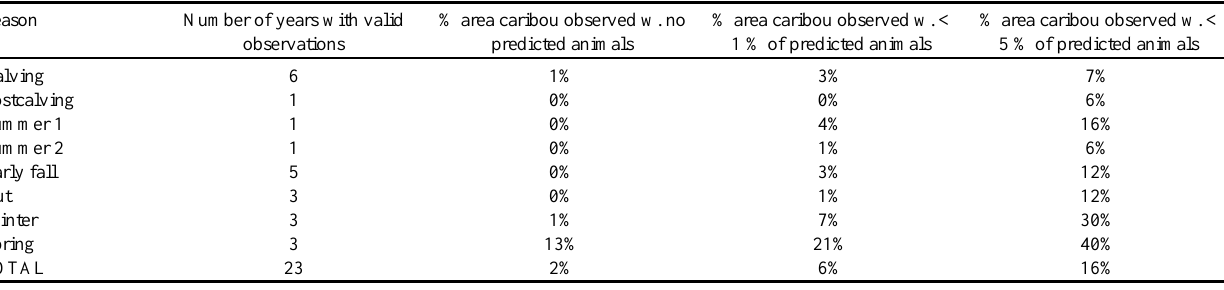
Table 5 . Mean percent of area of caribou distribution observed by Russell et al. (1992) in subzones with few or no predicted